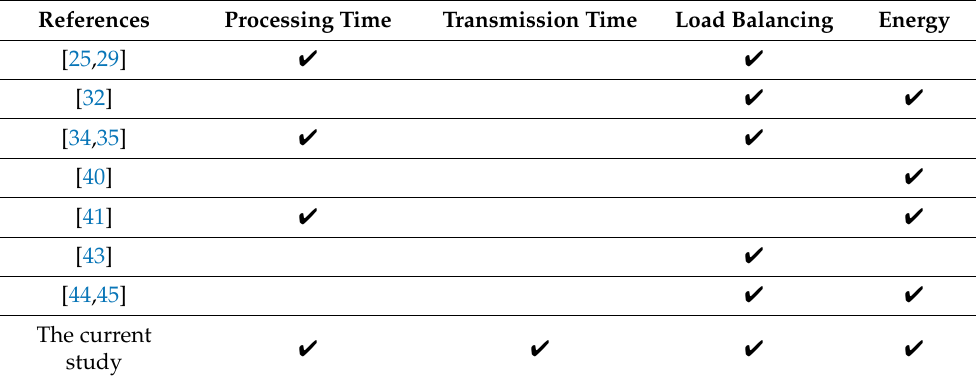
Table 1. Comparison of the proposed algorithms in this study.